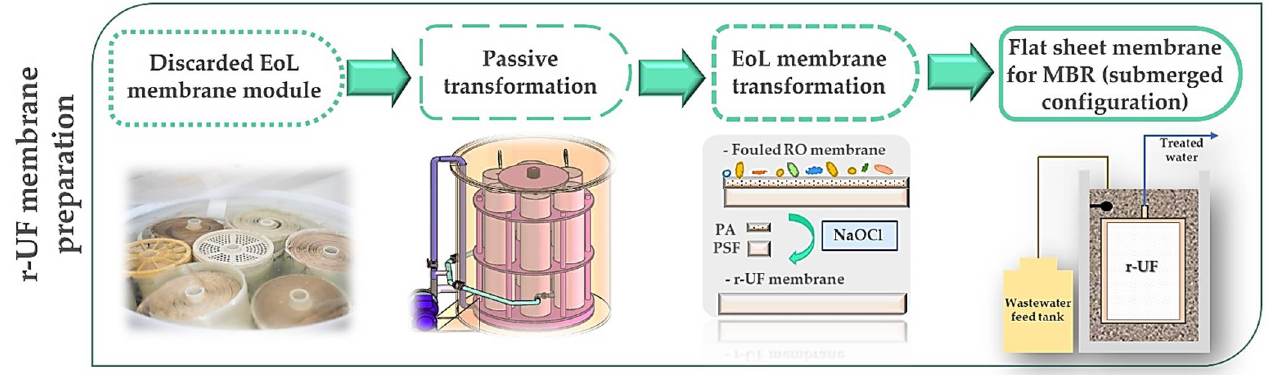
Figure 1. r-UF membrane preparation flow